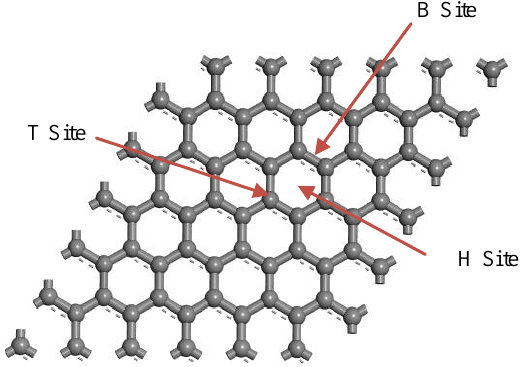
Figure 2. Three possible doping sites for an Ag atom.